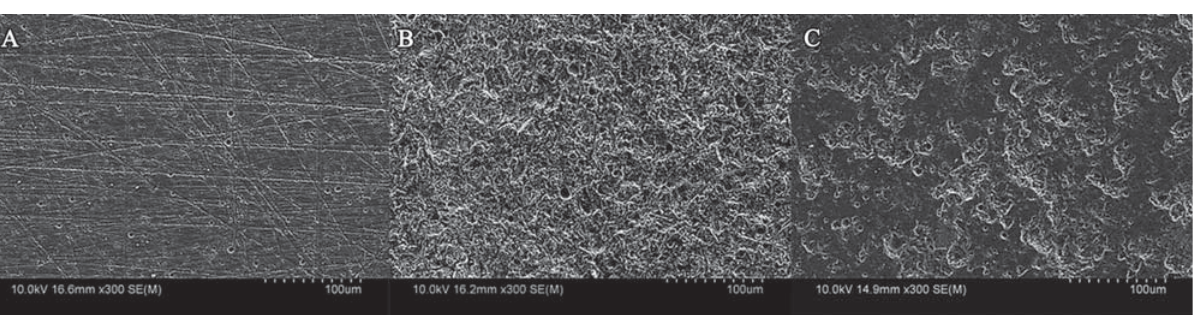
Figure 3- Scanning electron micrographs of the surfaces of the Block HC (BHC) specimens after different